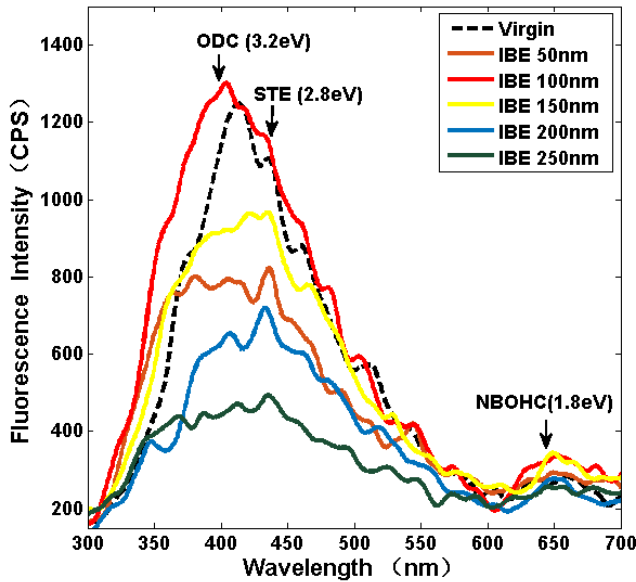
Figure 3. Fluorescence spectra analysis with various IBE depths.